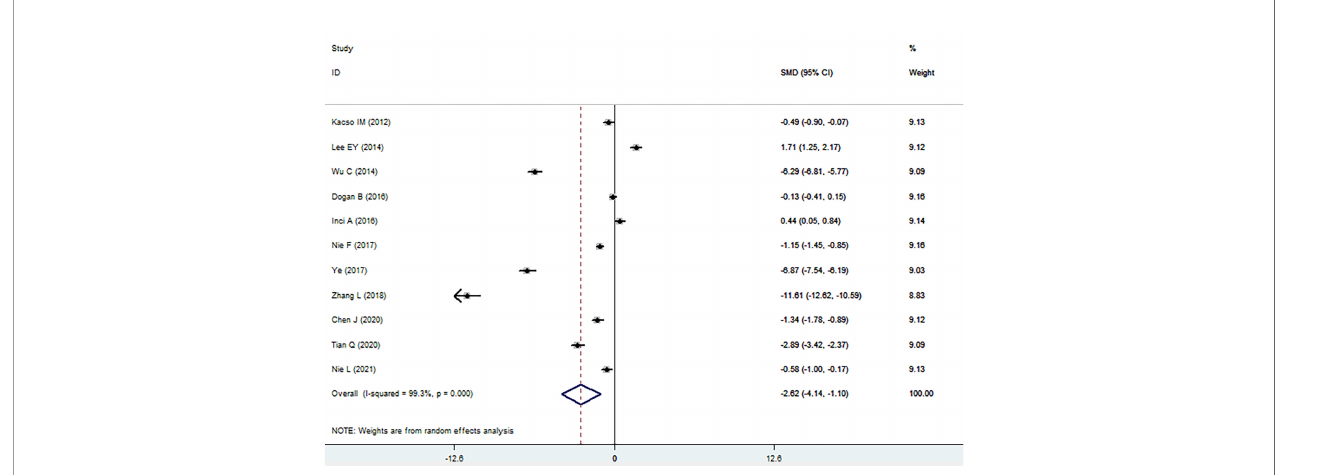
FIGURE 4 | Forest plots and funnel plots of sKlotho level in patients with diabetes compared to the controls. Diamond represents the pooled SMDs at 95% CI. SMD, standardized mean difference; CI, con fi dence interval.